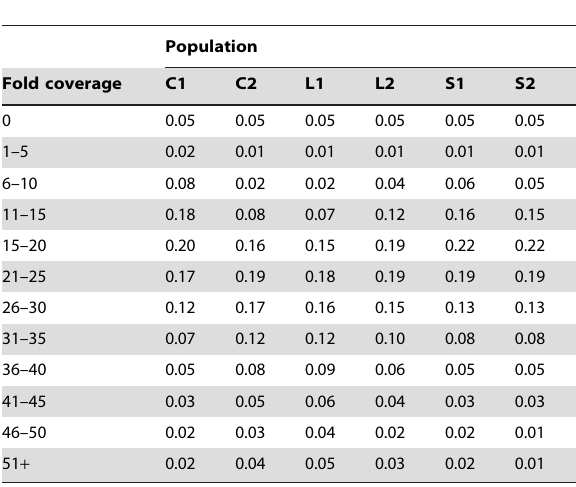
Table 1. Proportion of the euchromatic genome with a given fold coverage in each population.